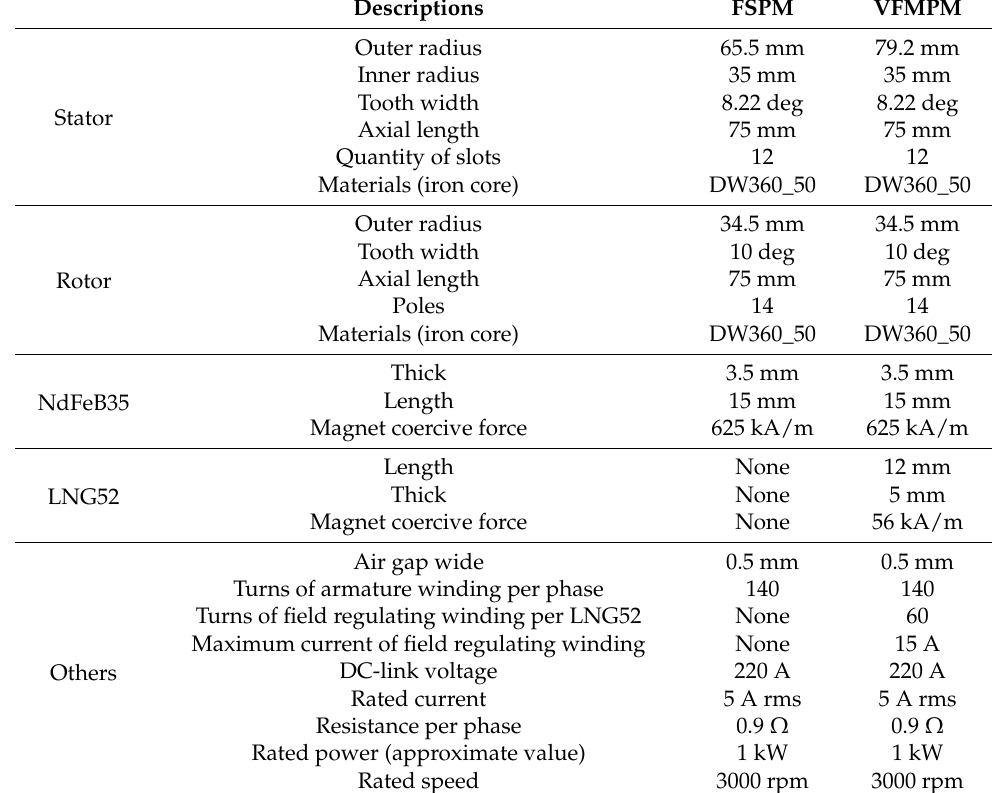
Table 1. Main dimension parameters of FSPM machine and VFMPM